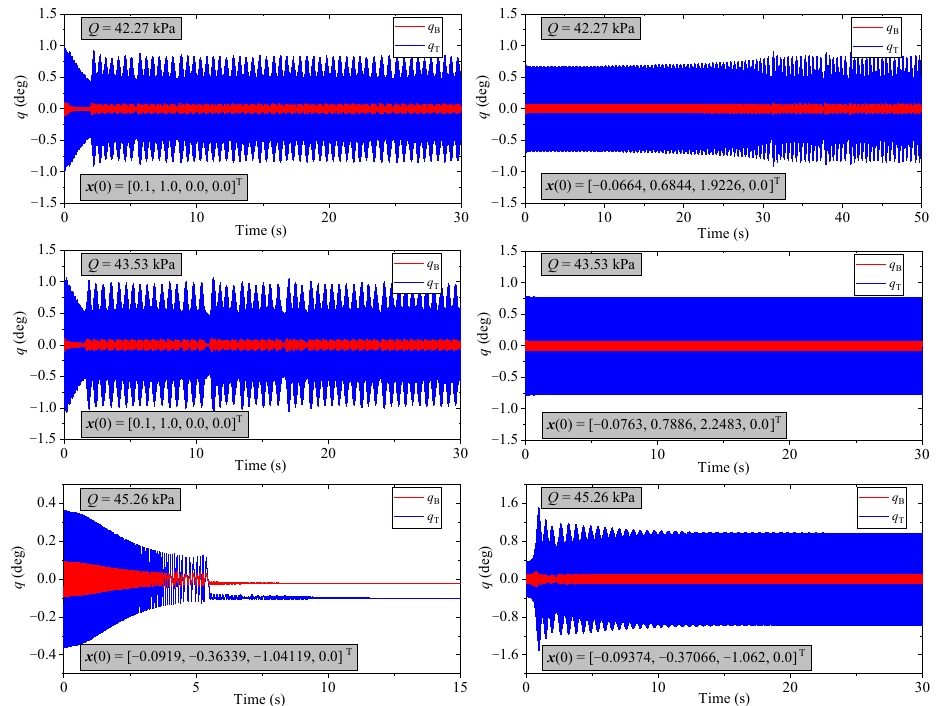
Figure 16. Time responses of systems at different dynamic pressures and initial conditions. ( Q = 42.27 kPa: harmonic initial conditions of branch A ( right ); Q = 43.53 kPa: harmonic initial conditions of branch A ( right ); Q = 45.26 kPa: harmonic initial conditions of branch B ( left ), 1.02 times the left initial conditions ( right ). δ B / δ T = 0.1. The phase parameter φ c of the harmonic initial condition is set to π